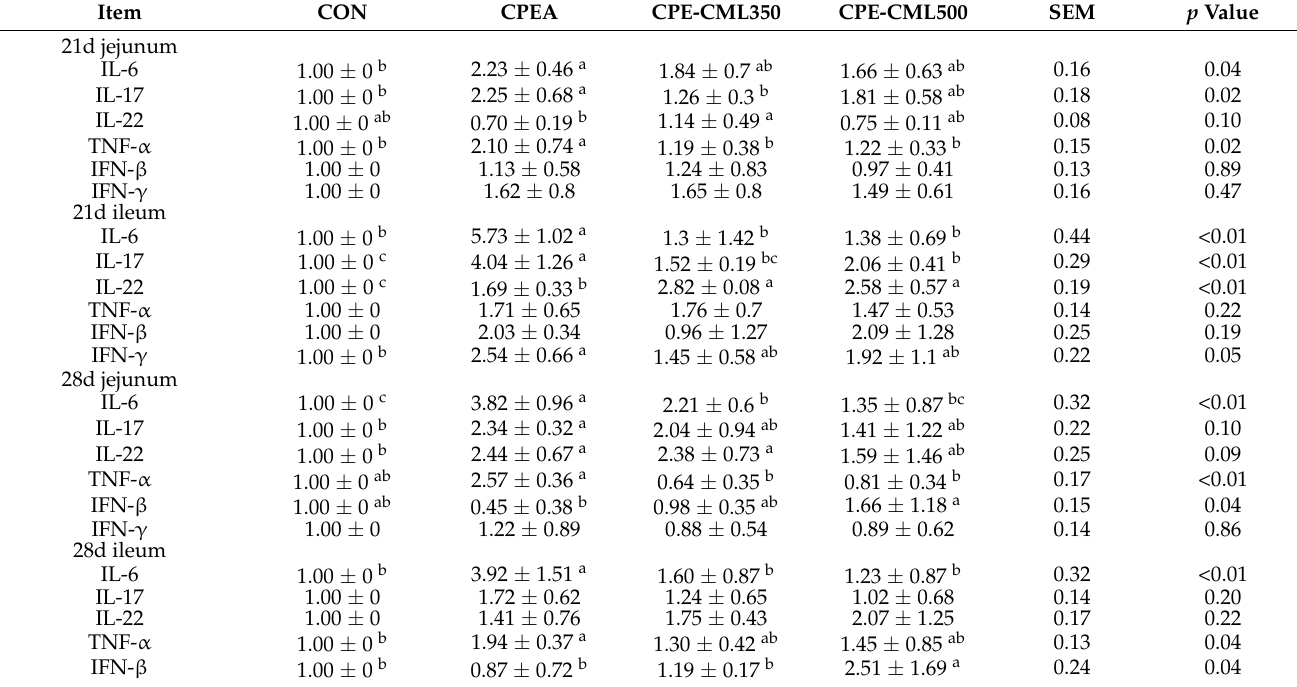
Table 5. Intestinal mucosal inflammatory factors.